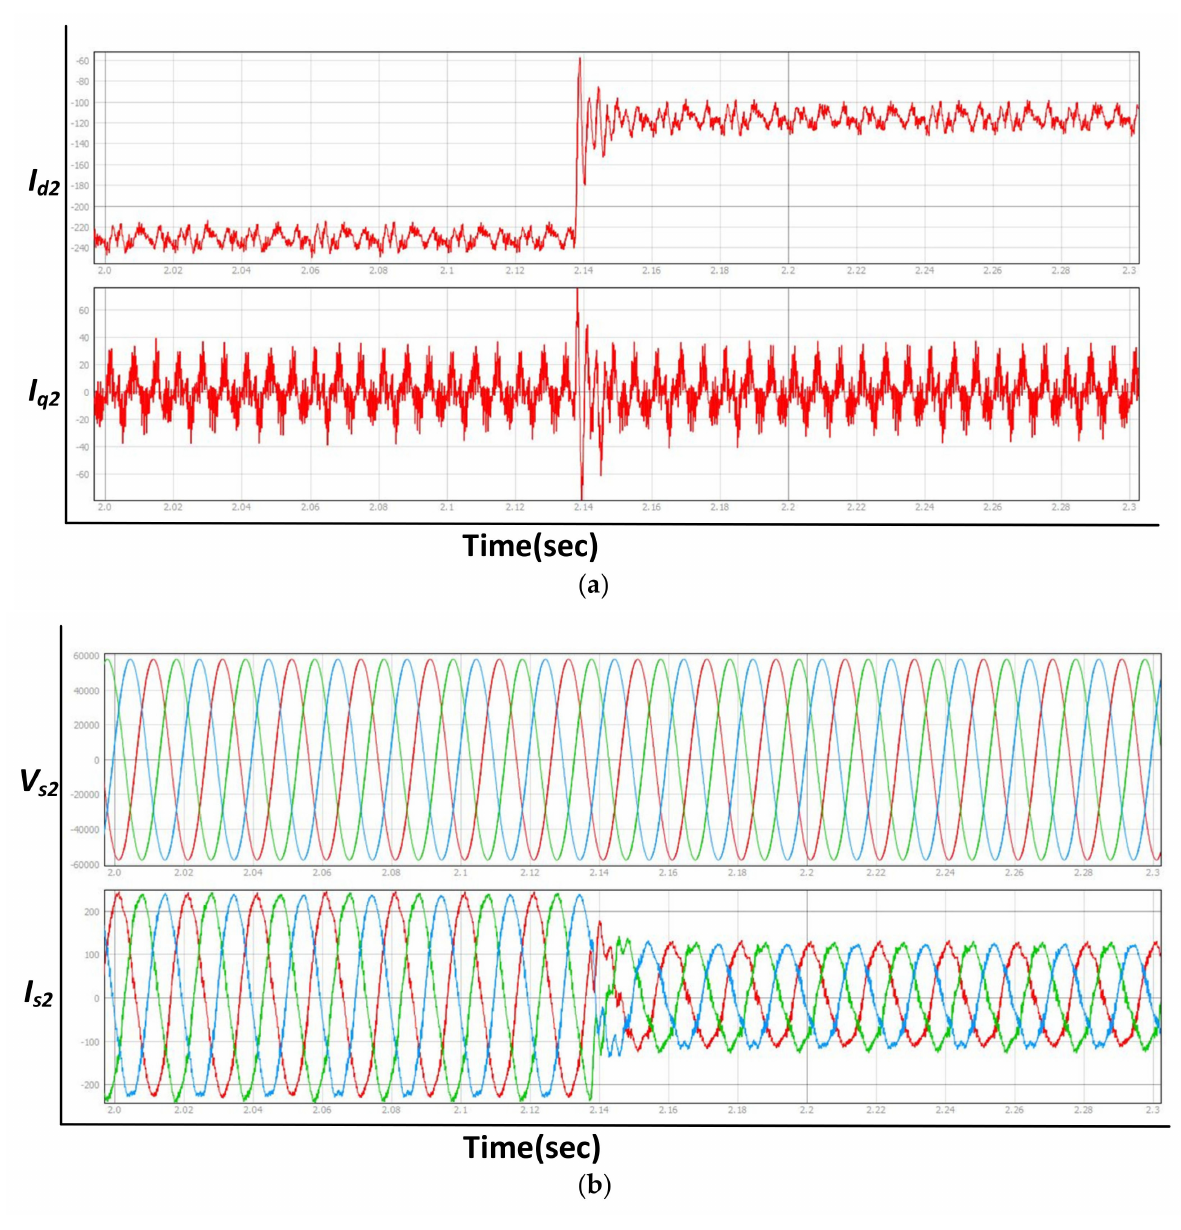
Figure 21. ( a ): Experimental results for the off-nominal case for I d2 , I q2 of Station 2 for a 50% step change in active power; ( b ): experimental results for the off-nominal case for V s2 (three phase votlages) and I s2 (three line currents) of Converter Station 2 for a 50% step change in active